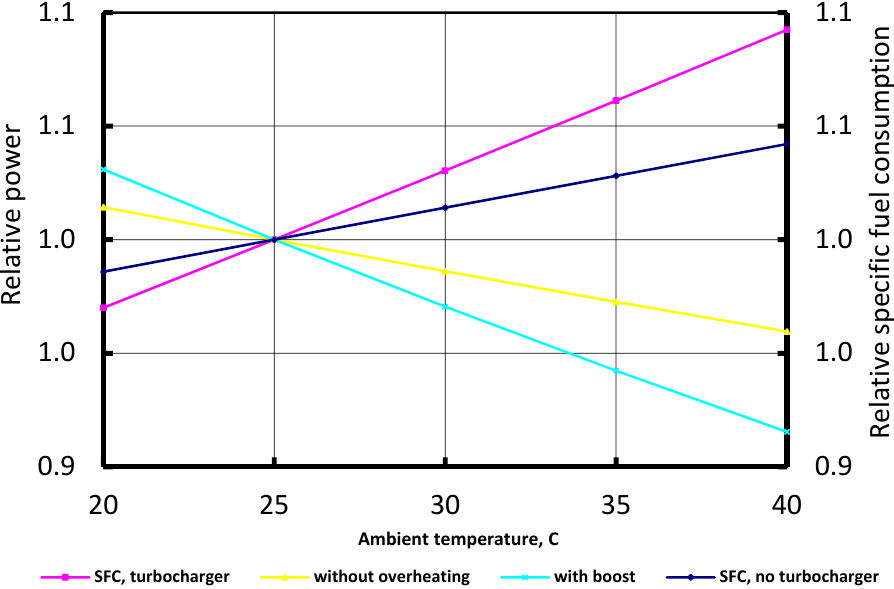
Figure 14. Power and specific fuel consumption as a function of air temperature. Source: developed by authors.